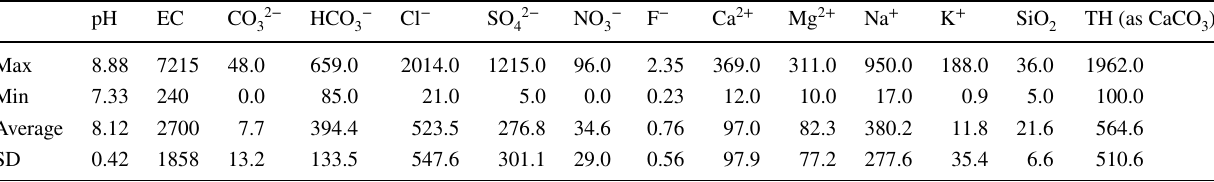
Table 4 Statistical properties of the observed geochemical